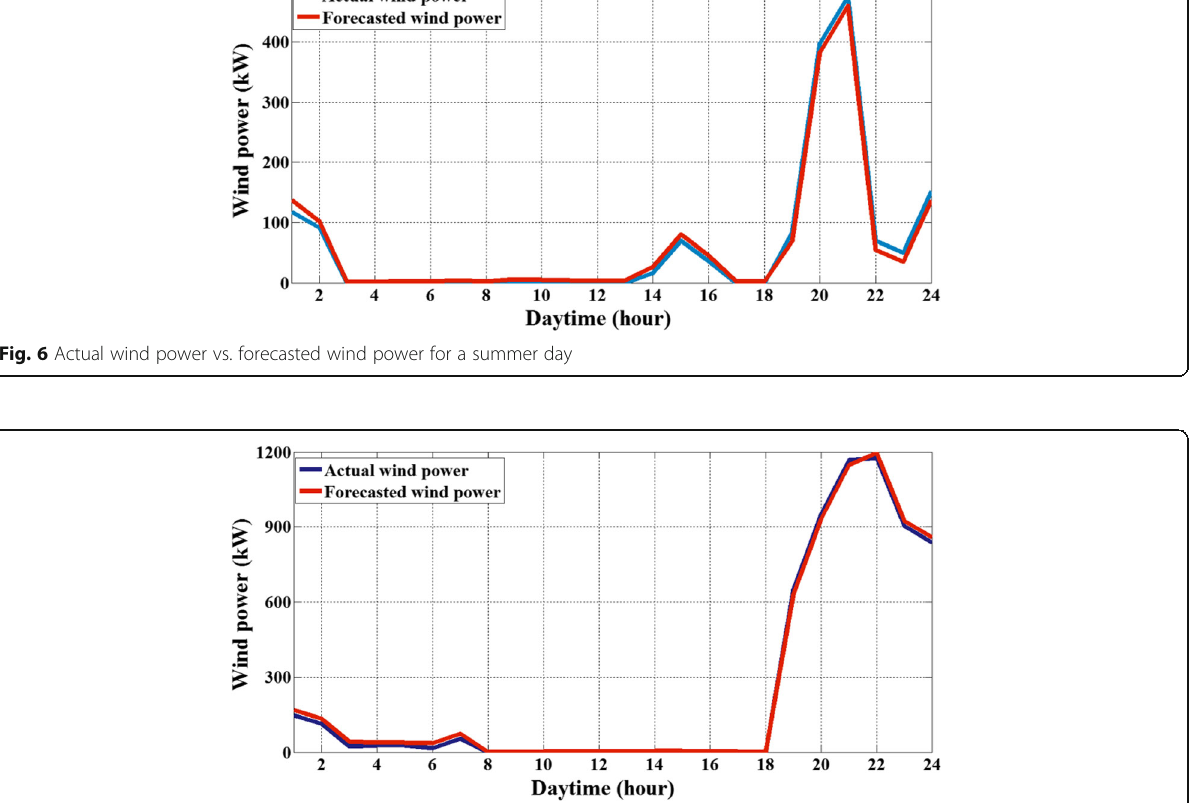
Fig. 7 Actual wind power vs. forecasted wind power for a fall day